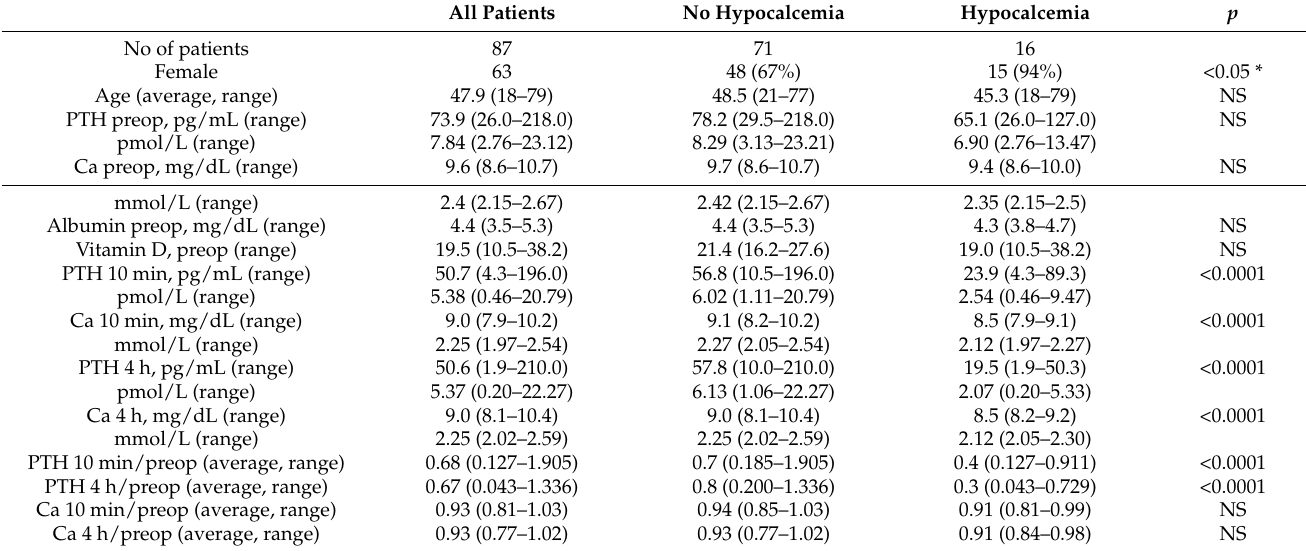
Table 1. Patient characteristics based on the presentation of hypocalcemia or not.